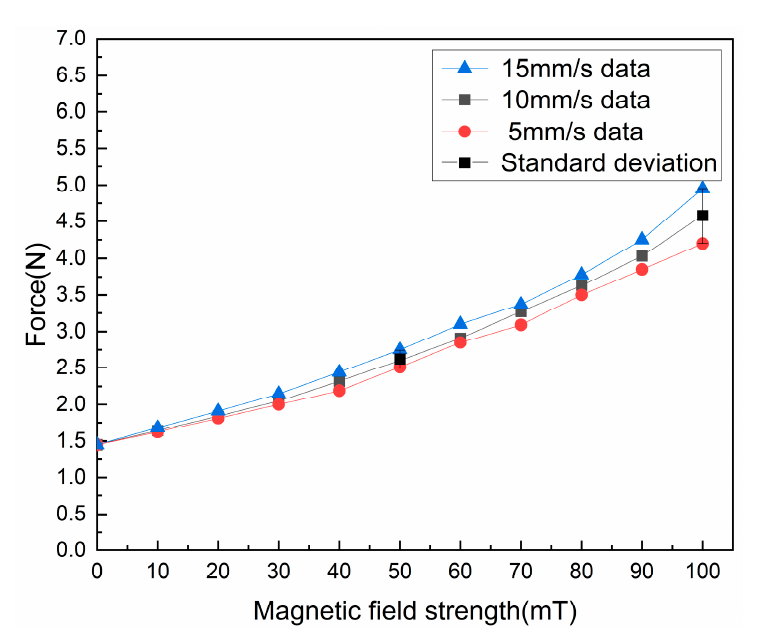
Figure 13. Experimental setup.